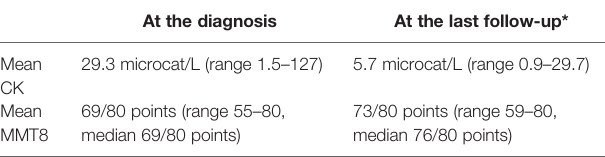
TABLE 3 | Disease course in anti-HMGCR – positive patients. At the diagnosis